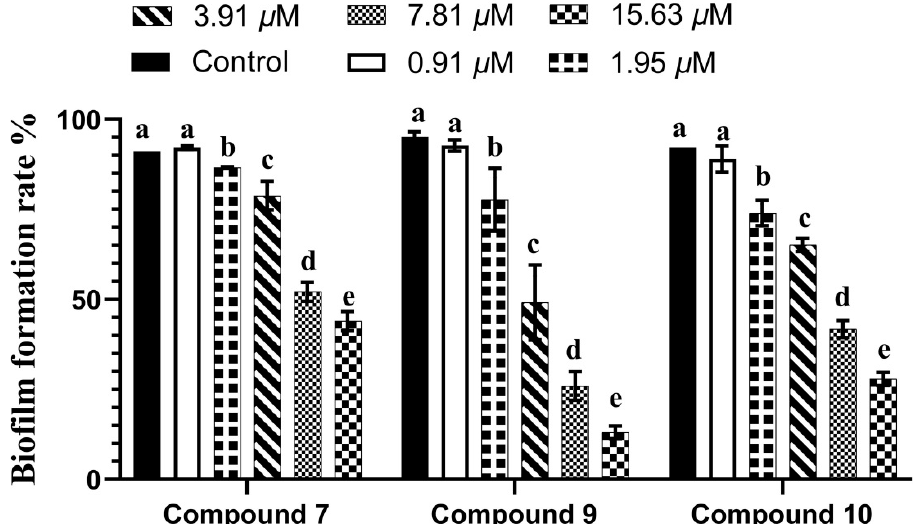
Figure 6. Inhibitory rate of compounds 7 , 9 and 10 on C. violaceum biofilm formation. Note: Biofilm formation of C. violaceum was quantified at OD 490 nm in presence of compounds at 0–15.63 µ M 30 °C after 24 h in 96-well plates. Columns represent means ± standard deviations. Bars with different letters (a–e) differ significantly ( p < 0.05).